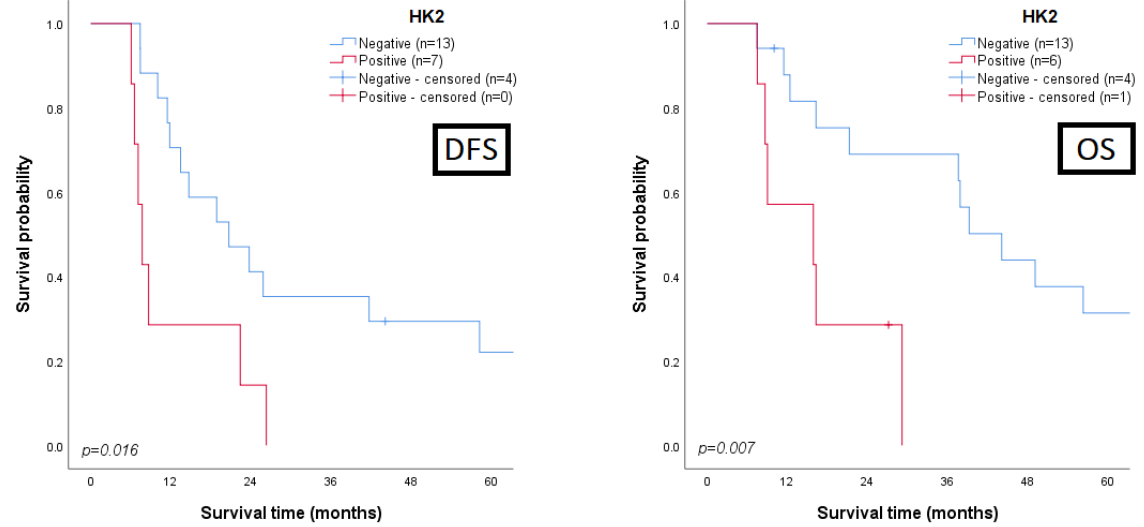
Figure 3. Kaplan–Meier curves demonstrating disease-free (DFS) and overall survival (OS) of patients with urothelial bladder carcinoma submitted to cisplatin-based therapy, based on HK2 (n = 24) immunoexpression status in the global tissue sections. p values from log-rank or Breslow tests.